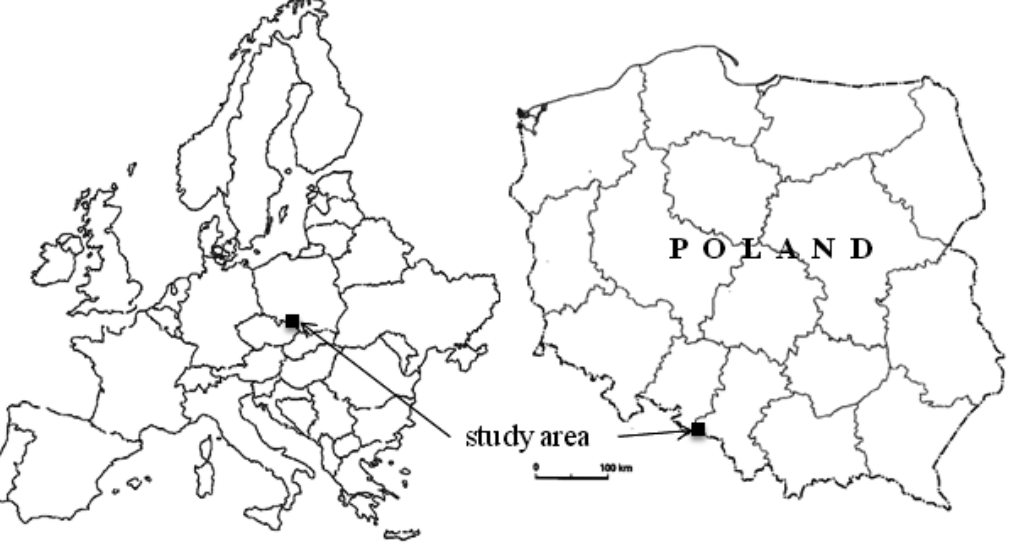
Figure 1. Location of the study area.